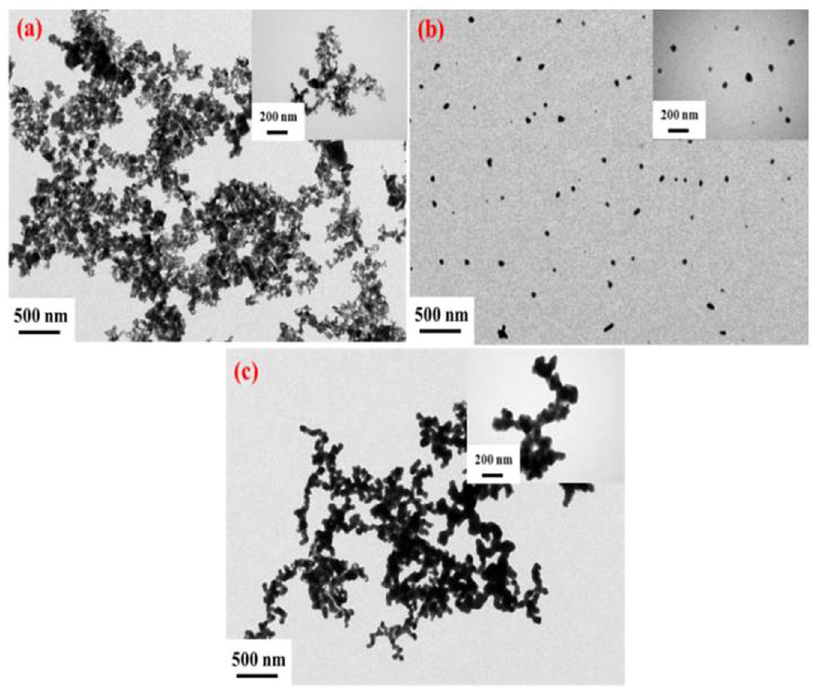
Figure 5. TEM pictures of GeAs ultrafine particles prepared at different temperatures ( a ) temperature = 1173 K; ( b ) temperature = 1223 K; ( c ) temperature = 1273 K.